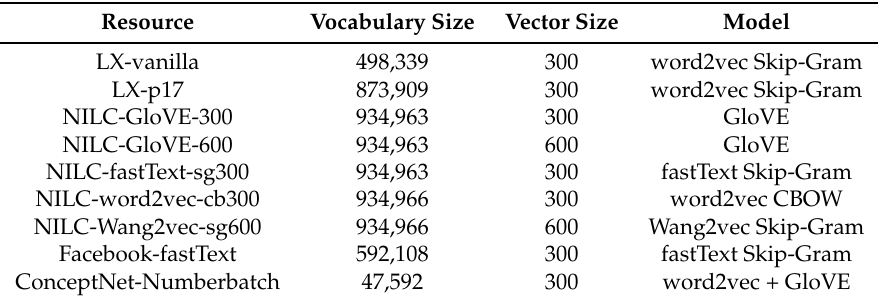
Table 5. Word embeddings used and their